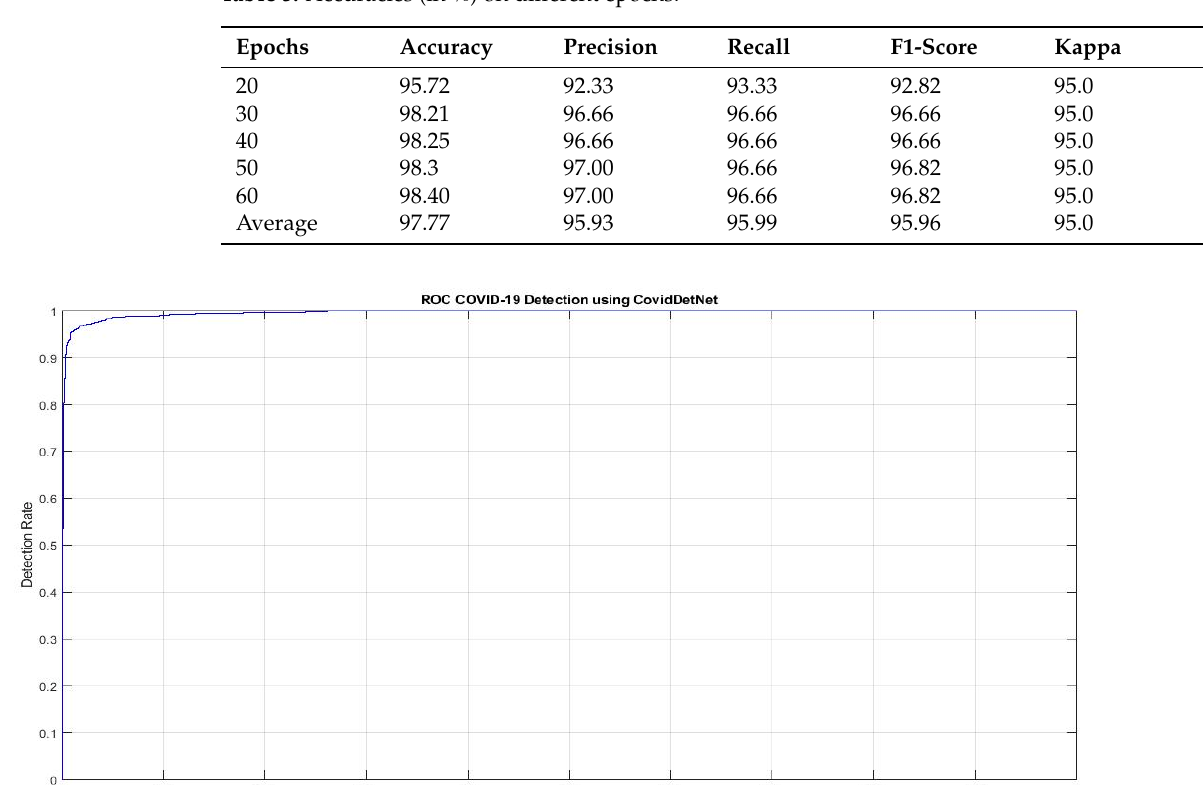
Table 5. Accuracies (in %) on different epochs.